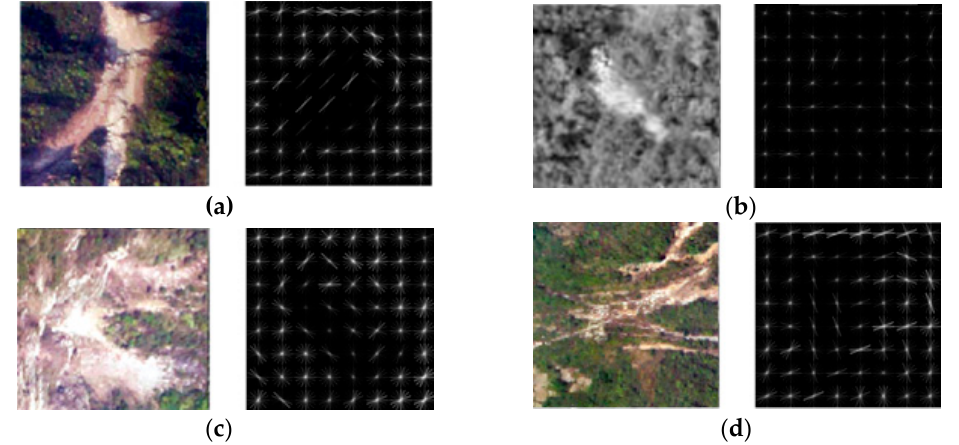
Figure 13. The visualization results of HOG feature of experimental landslide samples. ( a ) landslide sample 1 and HOG feature; ( b ) landslide sample 2 and HOG feature; ( c ) landslide sample 3 and HOG feature; ( d ) landslide sample 3 and HOG feature.